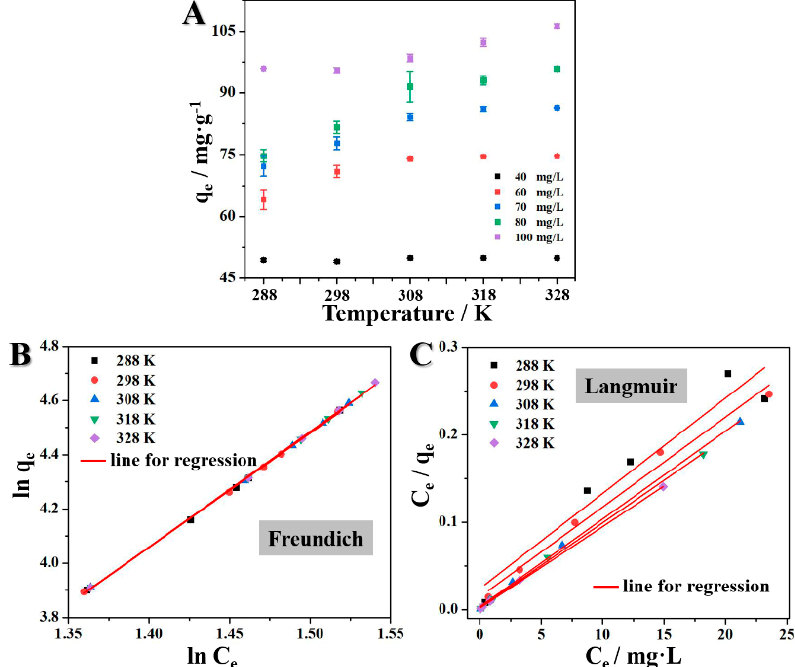
Figure 6. ( A ) Effect of temperature on the adsorption of RhB at different initial concentrations. ( B ) Freundlich and Langmuir isotherm plots of the adsorption.